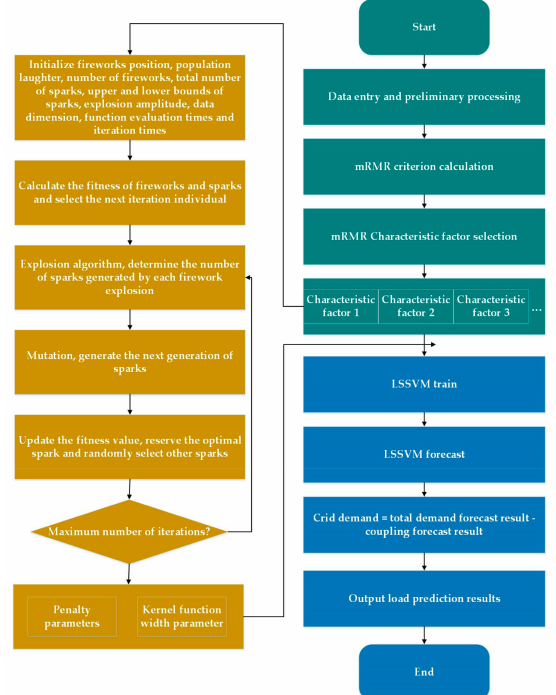
Figure 6. Load demand forecasting model under multi-energy coupling (least squares support vector machine optimized by the minimal redundancy maximal relevance model and the adaptive fireworks algorithm—mRMR-AFWA-LSSVM). mRMR: minimal redundancy maximal relevance; LSSVM: minimal redundancy maximal